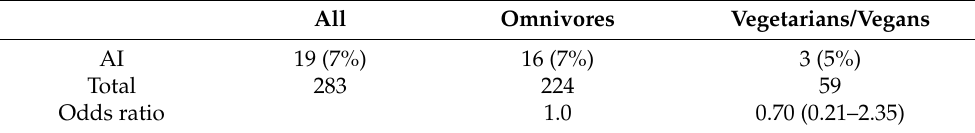
Figure 1. Total (dietary and supplementary) daily choline intake in all ( n = 273), omnivorous ( n = 217) and vegetarian/vegan ( n = 56) participants (outliers excluded). The red dotted line represents the choline AI of 480 mg/day. Data are presented as median with whiskers from ‘min to max’ and was analyzed with Kruskal–Wallis test following the Dunn’s test for multiple comparisons (** adjusted p value < 0.01; *** adjusted p value < 0.001). Table 2. Participants who met the adequate choline intake (AI) of 480 mg/d.